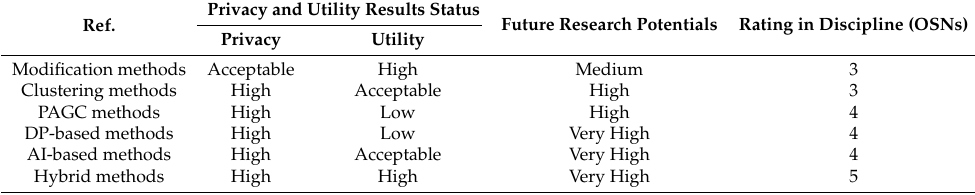
Table 7. Comparison of anonymization methods (a.k.a. privacy-preserving solutions) used in OSNs. Ref.